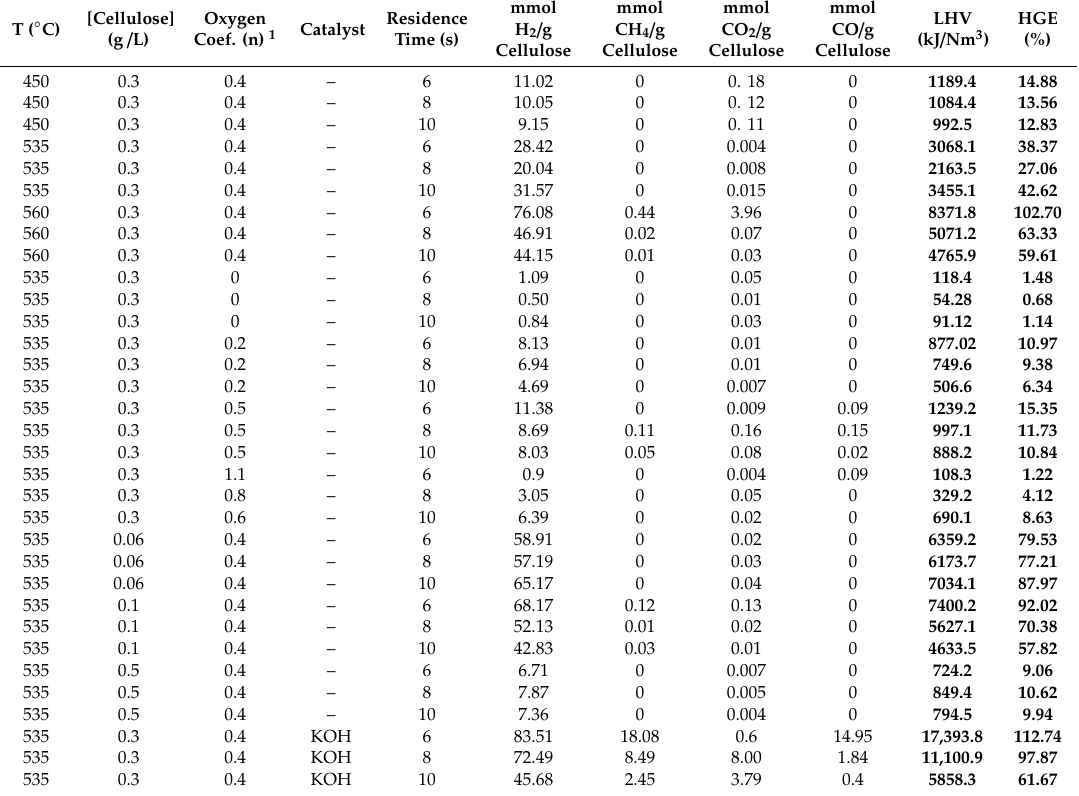
Table 2. Summary of the operating conditions and results from the cellulose SCWG